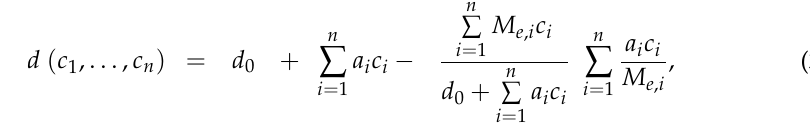
Table 8. Parameters in Equation (23) adjusted for two‑component systems [59] using the Excel solver. Electrolyte a b NaCl 0.0409 0.0008 NaOH 0.0433 0.0015 KOH 0.0479 0.0013 KCl 0.0467